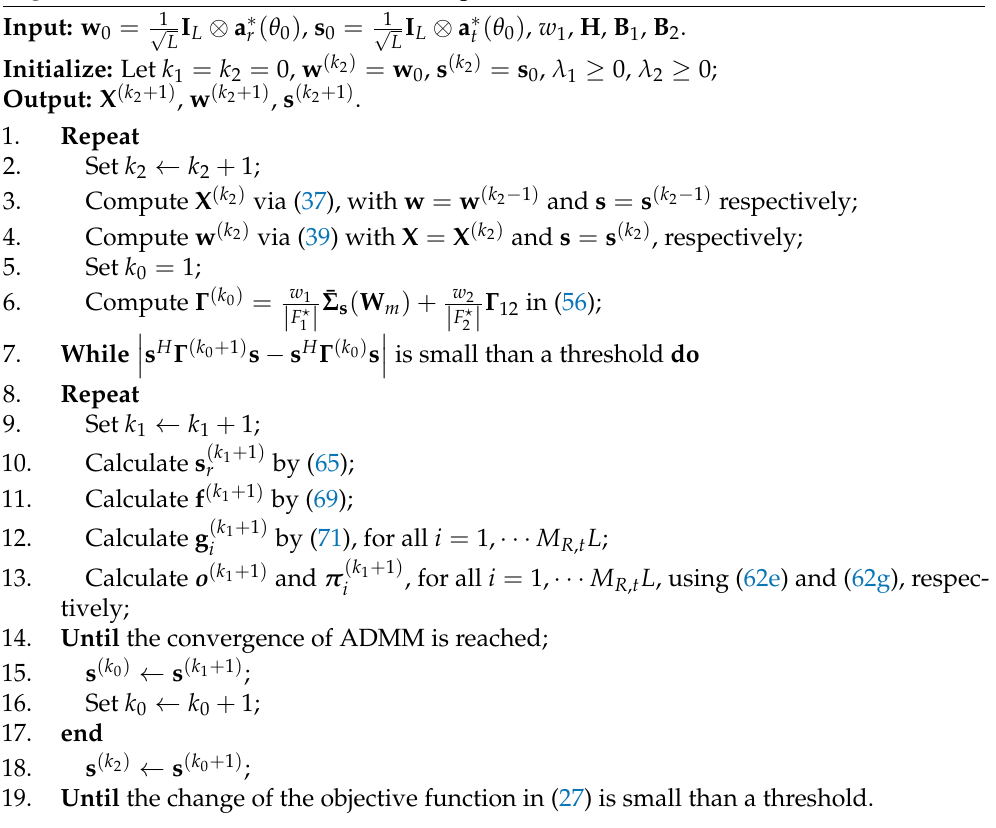
Algorithm 1 Procedure for X , w m and s